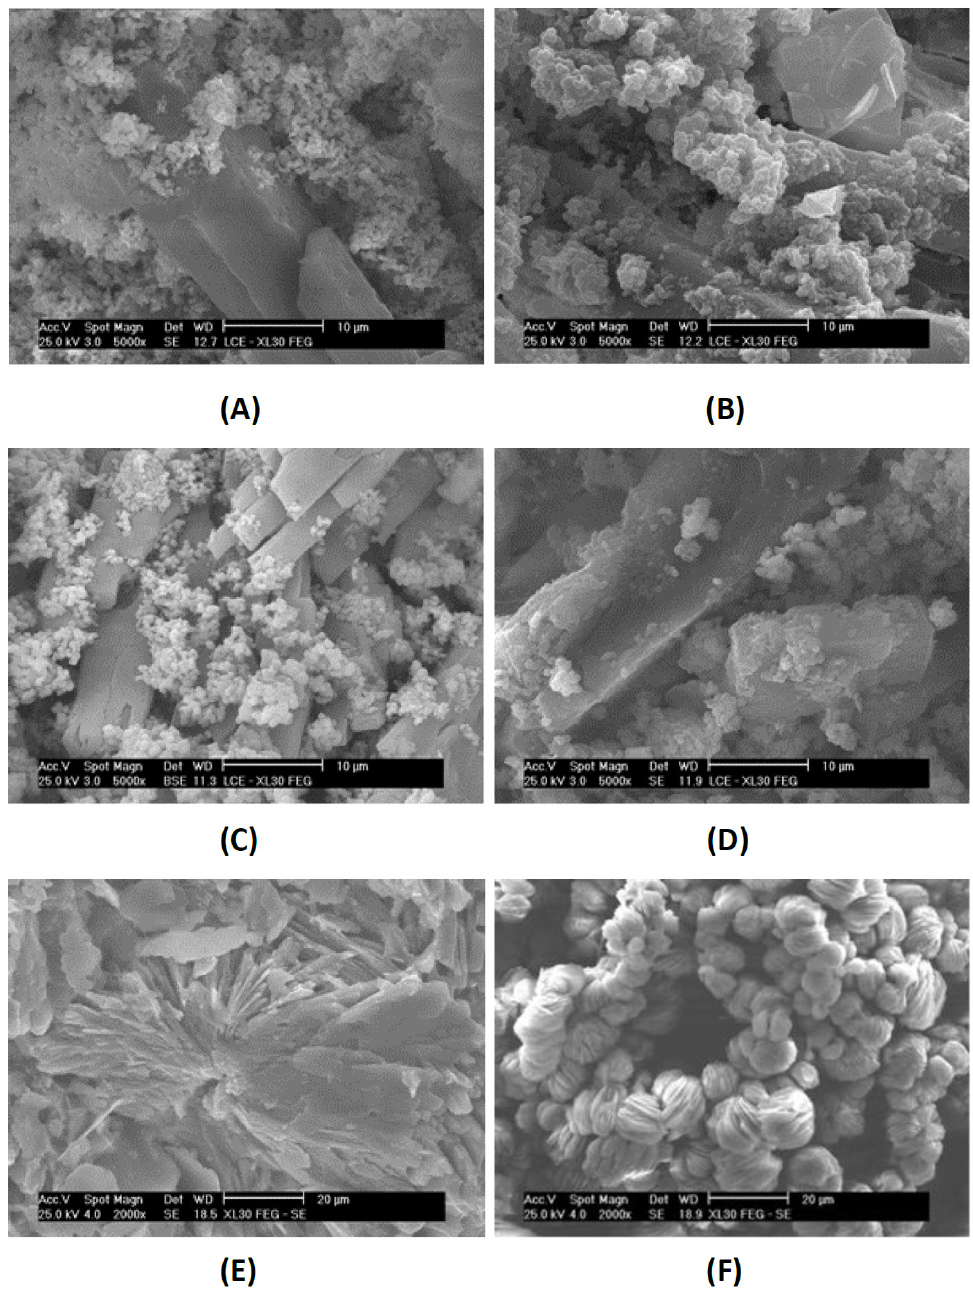
Figure 14. Microstructure of the magnesium phosphate cements prepared from MgO powders calcined at 1100 °C / 2 h. (A) C_01; (B) C_02; (C) C_03; (D) C_04; (E) struvite in composition C_S; (F) dittmarite in composition